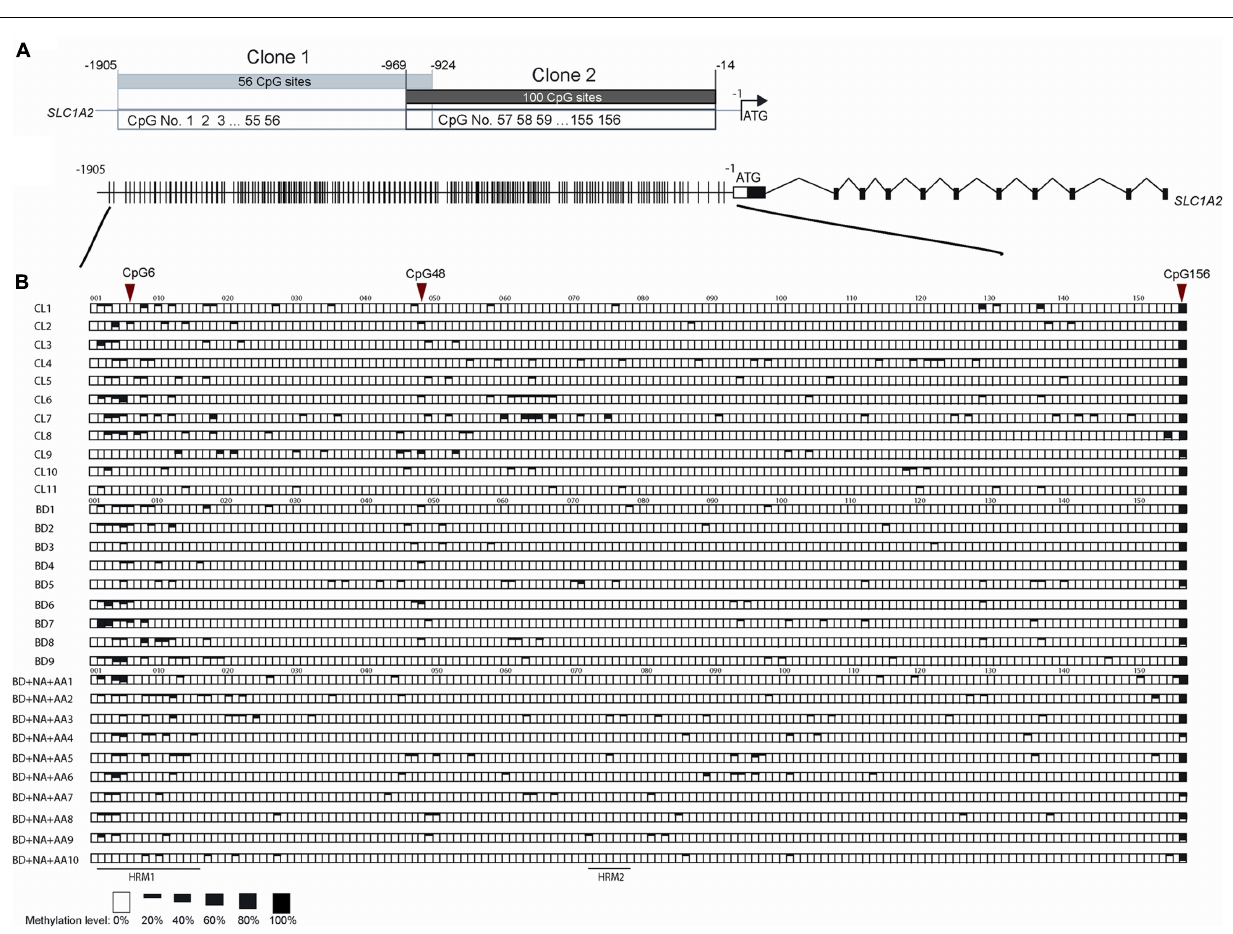
FIGURE 4 | The methylation pattern of individual CpG sites on SLC1A2 promoter region. (A) The profile of two clones in TA cloning and DNA sequencing method, shared 45 bp overlap, covered 156 CpG sites during –1905 to –14 of SLC1A2 promoter. (B) The gene profile of SLC1A2 . Distribution of CpG sites on the proximal SLC1A2 promoter. The individual lines in the promoter denote each CpG site (Top panel). Sequences from multiple clones ( n ≥ 5 from two replicate experiments for each condition) in each subject were examined. The methylation level of individual CpG sites in each subject from three groups including healthy control subjects (CL), bipolar disorder (BD) without alcohol abuse or dependence (AA), nicotine dependence (ND), and binge eating disorder or bulimia nervosa, and BD comorbid with ND and AA are shown in boxes (bottom panel). The average methylation percentages of individual CpG sites are shown in different size of black boxes. The empty box denotes 0% methylation level, while the total black box denotes 100% methylation